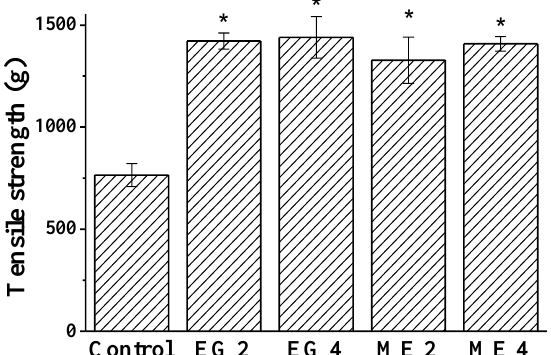
Figure 6. Tensile strength of healing wounds in control group and after treatment with different compositions, * p < 0.05 compared to control.